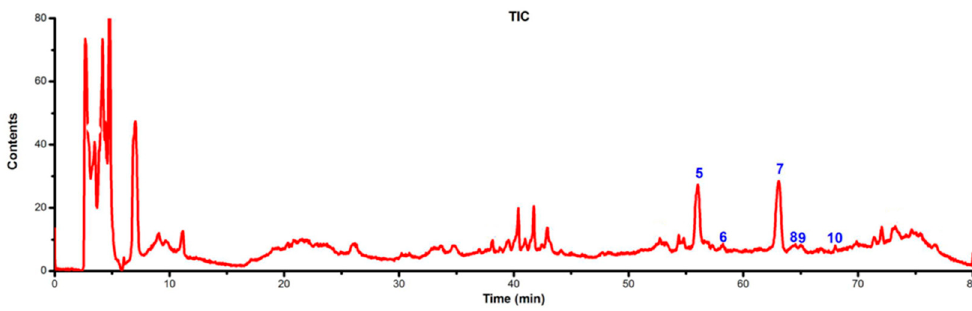
Figure 11. ESI-MS chromatograms of flavonoid extract of M. polymorpha L. archegoniophore.